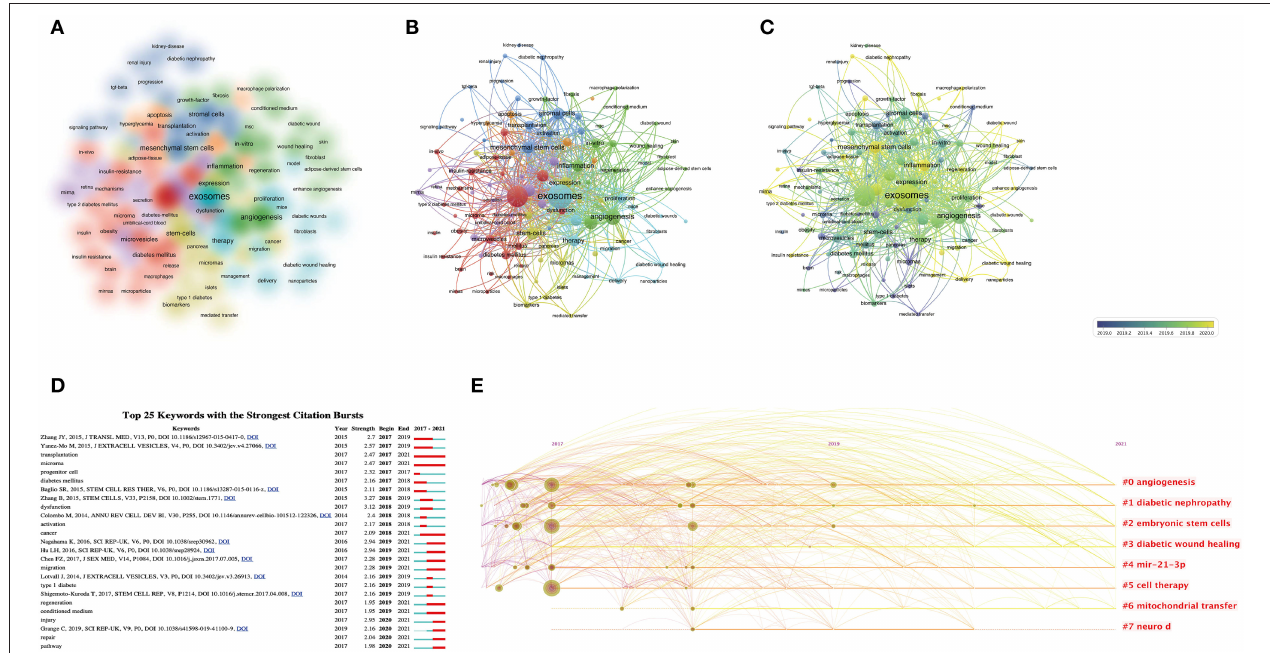
FIGURE 5 | Keyword mapping in studies on SC-EVs for diabetes. (A) Clustering analysis of key words based on VOSviewer. (B) Network visualization of keywords based on VOSviewer. (C) Chronological order of keywords based on VOSviewer. (D) The top 20 keywords with the strongest citation bursts based on CiteSpace. (E) Keyword timeline visualization from 2017 to